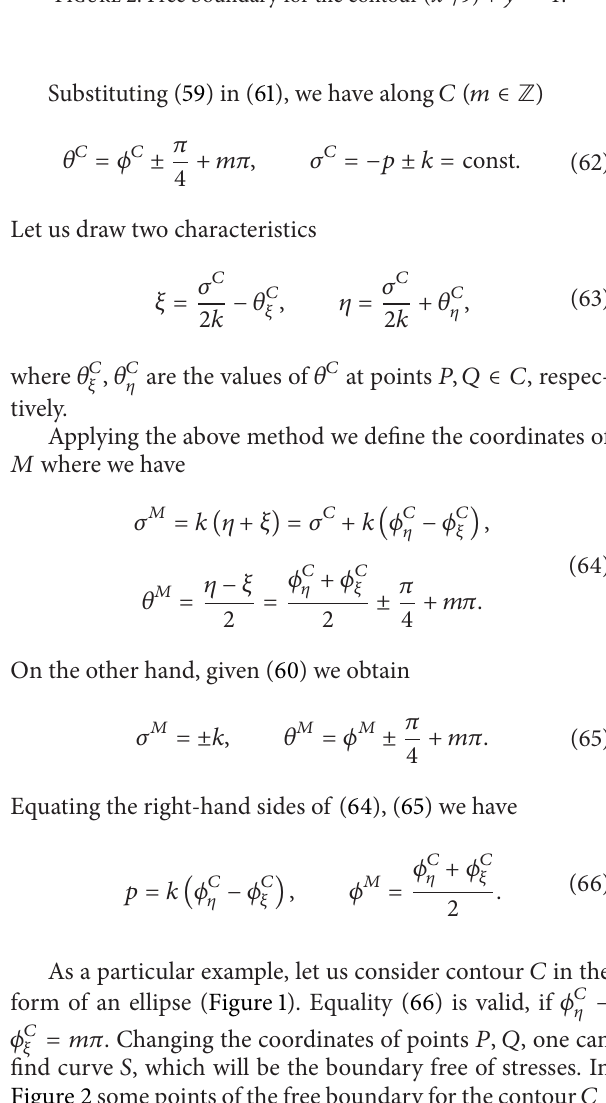
Figure 2: Free boundary for the contour (𝑥 2 /9) + 𝑦 2 = 1 .